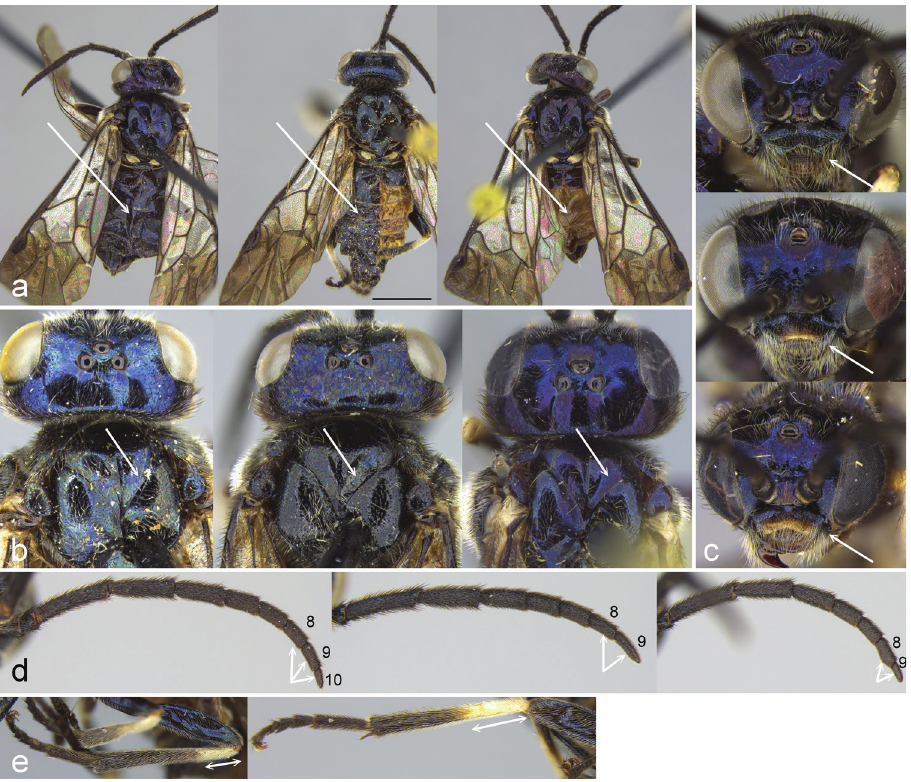
Figure 1. Neostromboceros albicomus , various specimens, both sexes. a color of abdomen (females, scale 2 mm) b color and density of pits on mesonotum c color and shape of clypeus d shape of apical anten- nomeres e color of hind